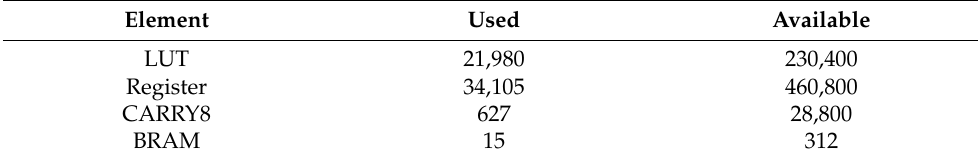
Table 3. Utilization of the ADC.